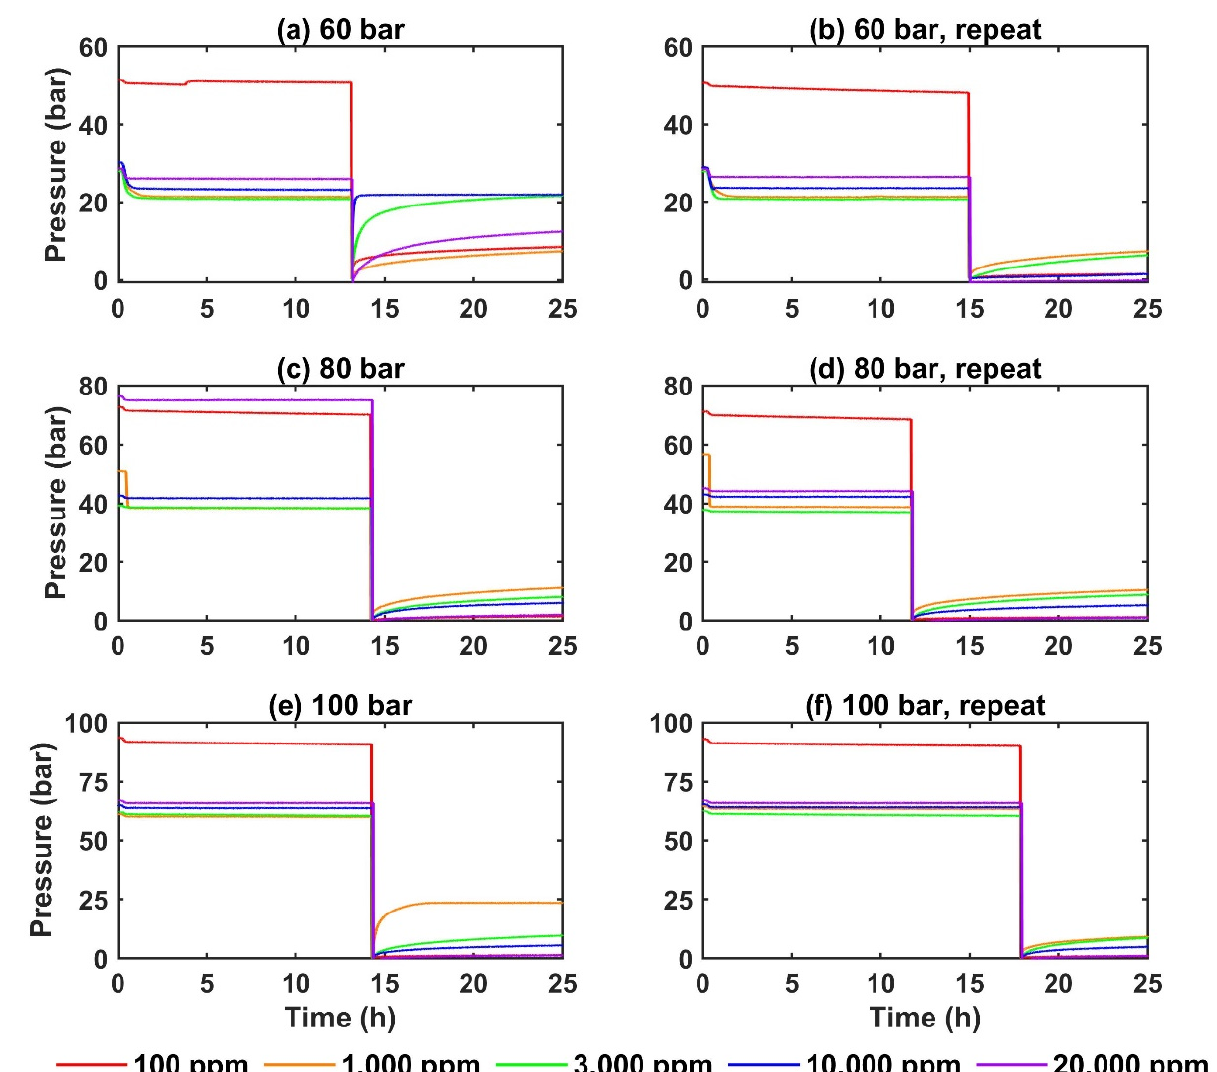
Figure 13. Pressure variation during cooling T < 0 ° C (in the presence of methionine) for five different concentrations (100 ppm to 20,000 ppm). First part of pressure variation on account of cooling below 0 °C (temperature reduced from 1 °C to − 2 °C) and second part of pressure variation due to self-preservation. For self-preservation, the pressure inside the cells was quickly reduced to atmospheric pressure and valve was closed (at T = − 2 °C) ( a , b ) show the pressure response curve for P 1 = 60 bar. ( c , d ) show the pressure response curve for P 1 = 80 bar. ( e , f ) show the pressure response curve for P 1 = 100 bar.